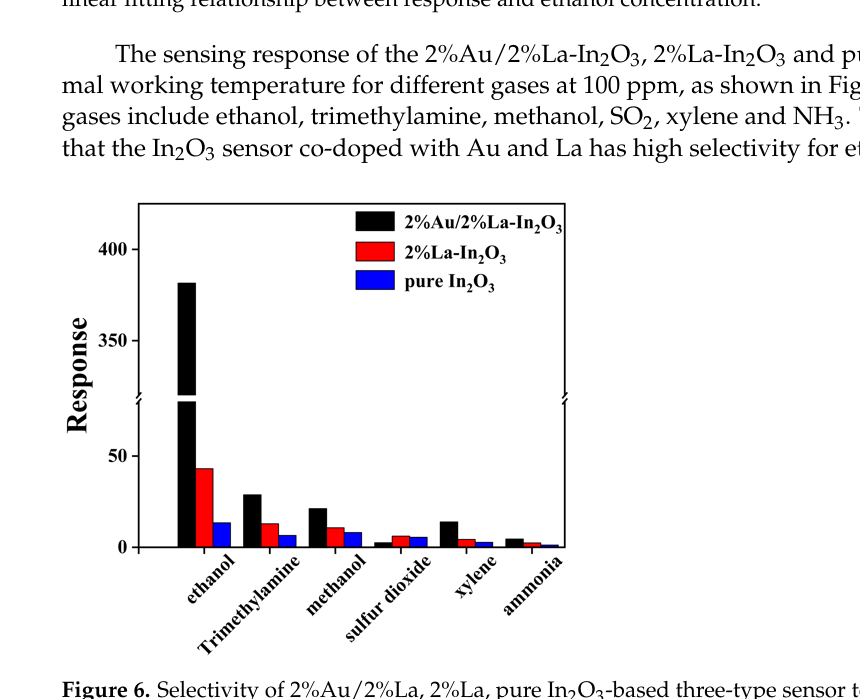
Figure 6. Selectivity of 2%Au/2%La, 2%La, pure In 2 O 3 -based three-type sensor to 100 ppm ethanol, trimethylamine, methanol, sulfur dioxide, xylene,